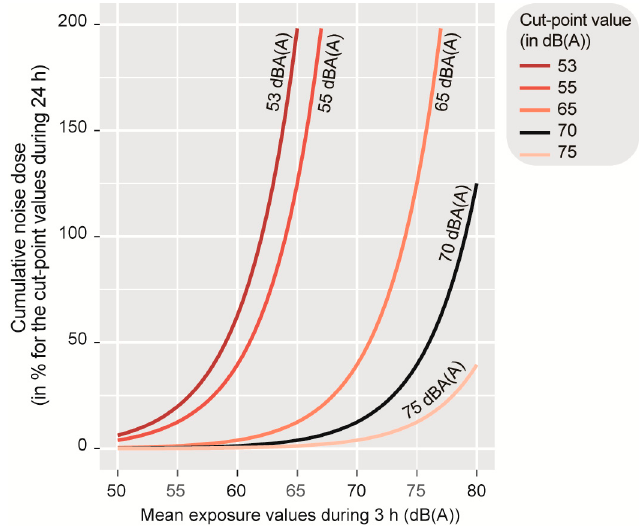
Figure 2. Estimated cumulative noise dose during 3 h by retained cutoffs.